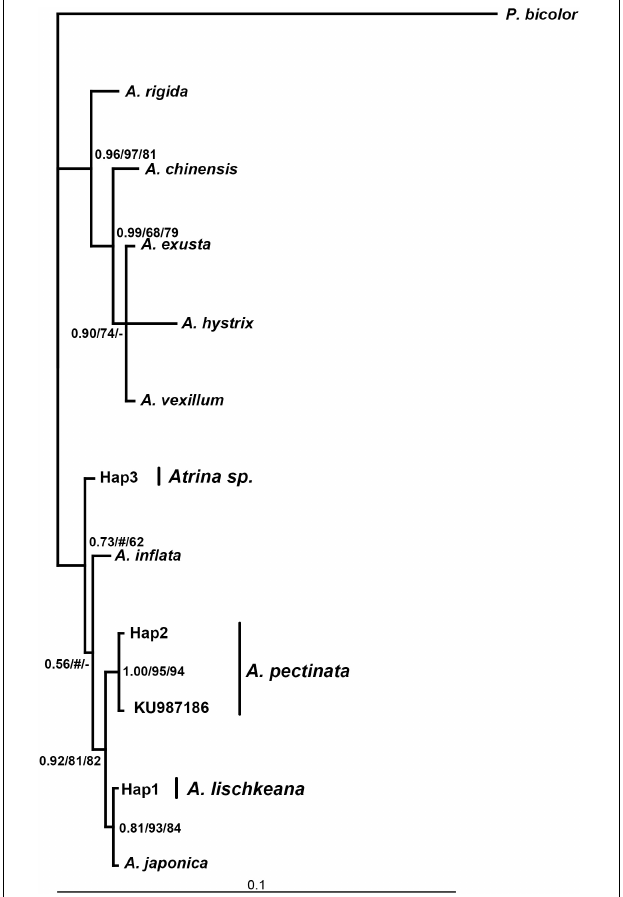
FIGURE 3 | Bayesian tree of 28S rRNA showing the phylogenetic placement of the four species in the A. pectinata species complex. The numbers at the nodes represent the Bayesian inference posterior probabilities, neighbor-joining, and maximum likelihood probability support.